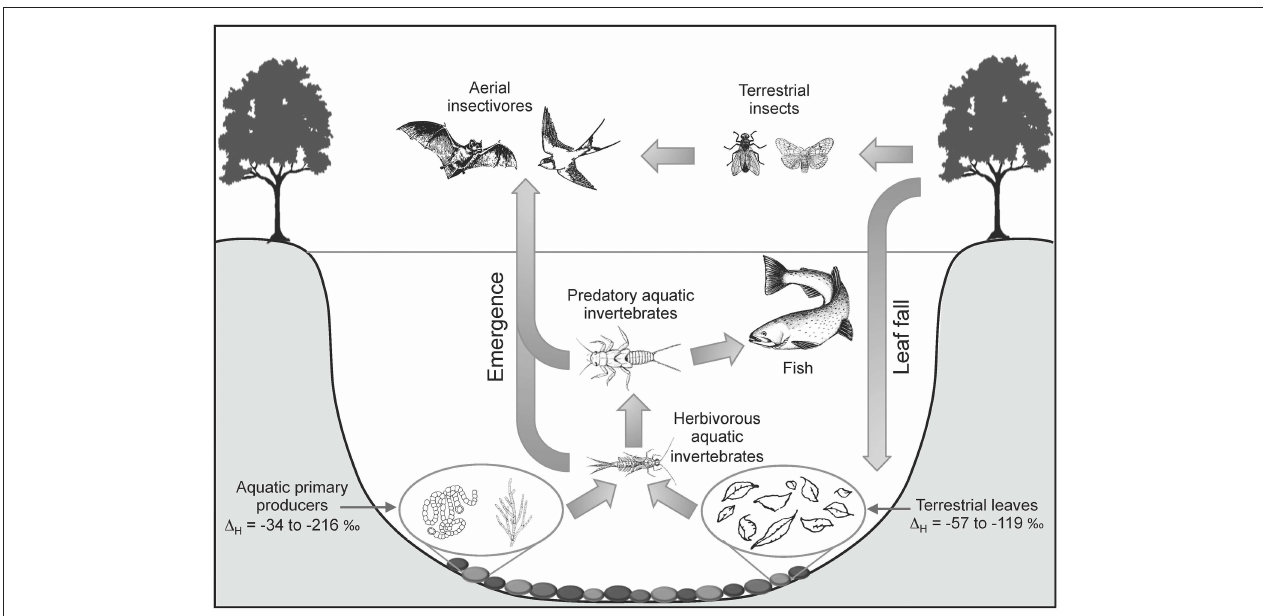
FIGURE 2 | Hydrogen isotope values are a useful tracer of land-to-water and water-to-land nutrient flow as a result in δ 2 H value differences between aquatic and terrestrial primary producers. The offset between δ 2 H water and δ 2 H producer ( 1 H , Equation 1) is typically larger for aquatic primary producers (excluding macrophytes) than for terrestrial vegetation. The range for aquatic primary producers include phytoplankton, macroalgae, and benthic microalgae in rivers, lakes, and coastal systems, while the terrestrial vegetation range includes both deciduous and evergreen species (compiled by Hondula et al., 2014). These isotopic profiles can be measured in organisms within the aquatic food web to determine the autochthonous vs. allochthonous nutrient inputs. Additionally, emergent aquatic insects may also provide important nutrient subsidies to the terrestrial ecosystem that can be detected in the δ 2 H values of insectivorous organisms. Figure adapted from Baxter et al.